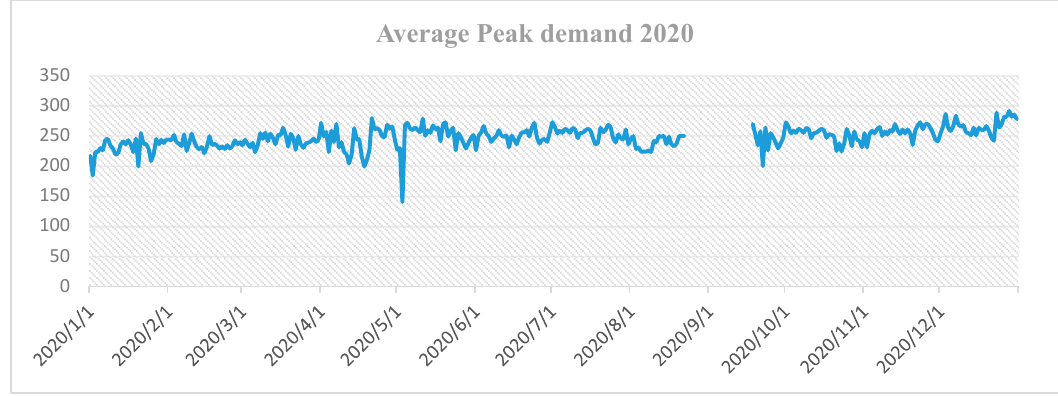
Figure 9. Simulated average peak demand for the year 2020.